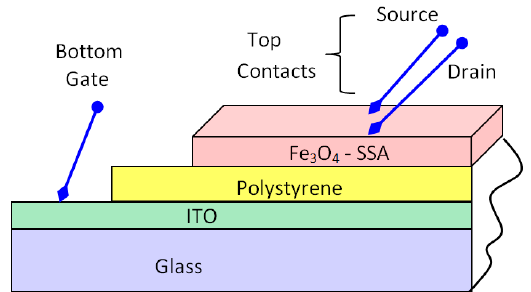
Figure 5. A schematic of the organic thin-film transistor (OTFT) structure, showing the successive layers and the three electrodes places: Gate in contact with the indium tin oxide (ITO), and the source and drain in contact with the Fe 3 O 4 –SSA film.